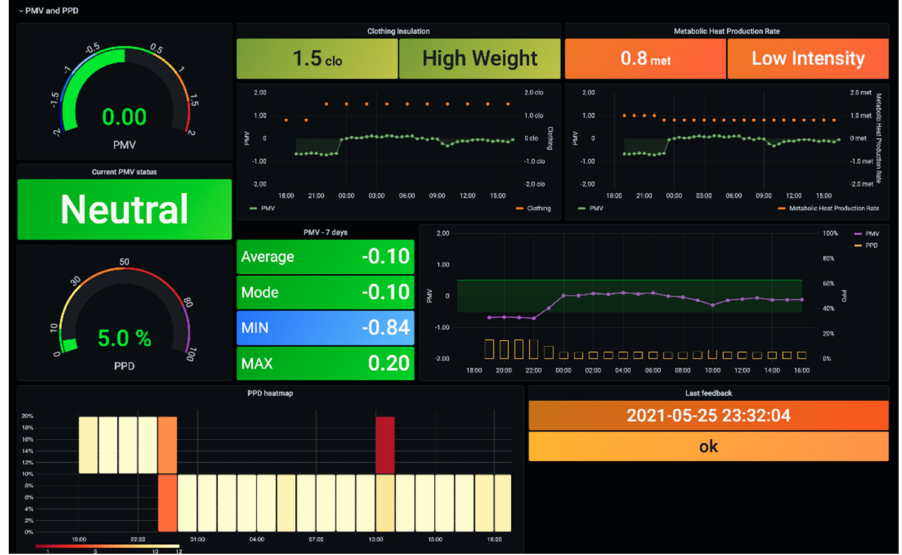
Figure 9. Sample view of the first dashboard section: PMV and PPD.